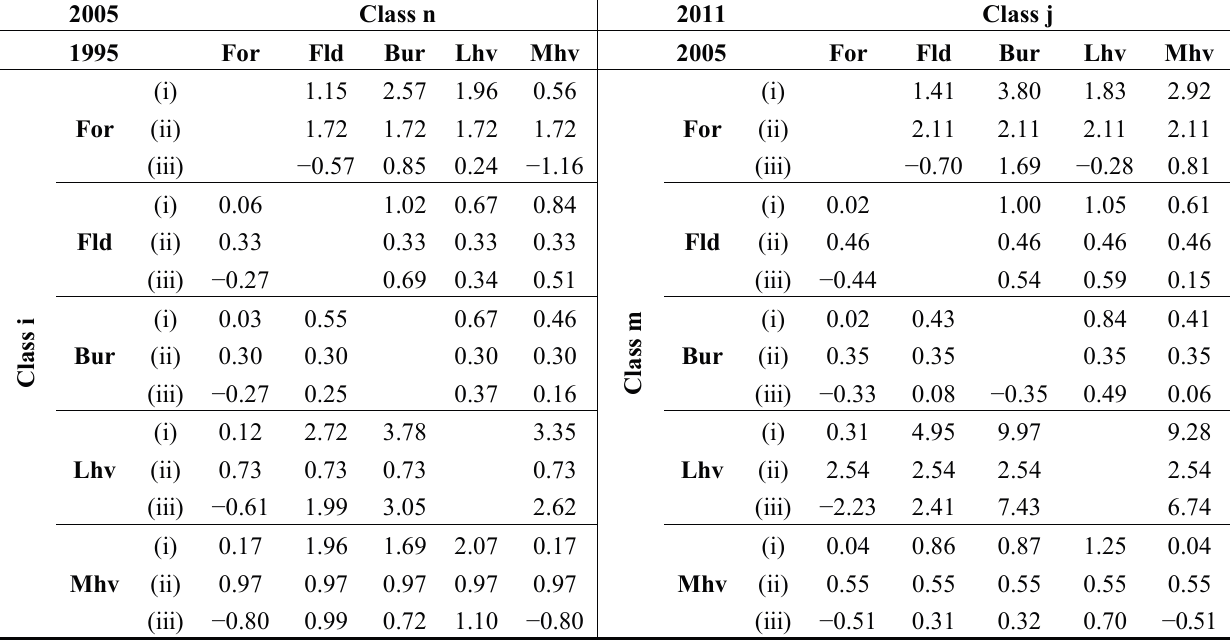
Table 7. Transition intensity analysis from the perspective of losses for the intervals 1995–2005 (l eft ) and 2005–2011 ( righ t): ( i ) Observed intensity: annual area of loss from class i to class n relative to the size of class n in 2005 (left table), and from class m to class j relative to the size of class j in 2011 (right table); ( ii ) Uniform intensity: area of gross loss of class i relative to the area of all non-i classes in 2005 (left table) and of class m relative to the area of all non-m classes in 2011 (right table); ( iii ) difference between observed and uniform intensity.